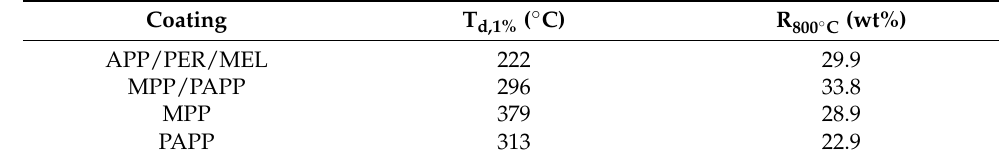
Figure 4. ( A )TGA curves of coating samples. ( B ) DTG curves of coating samples. Figure 4. ( A ) TGA curves of coating samples. ( B ) DTG curves of coating samples. Table 4. Thermogravimetric data of the flame retardant coatings in N 2 .